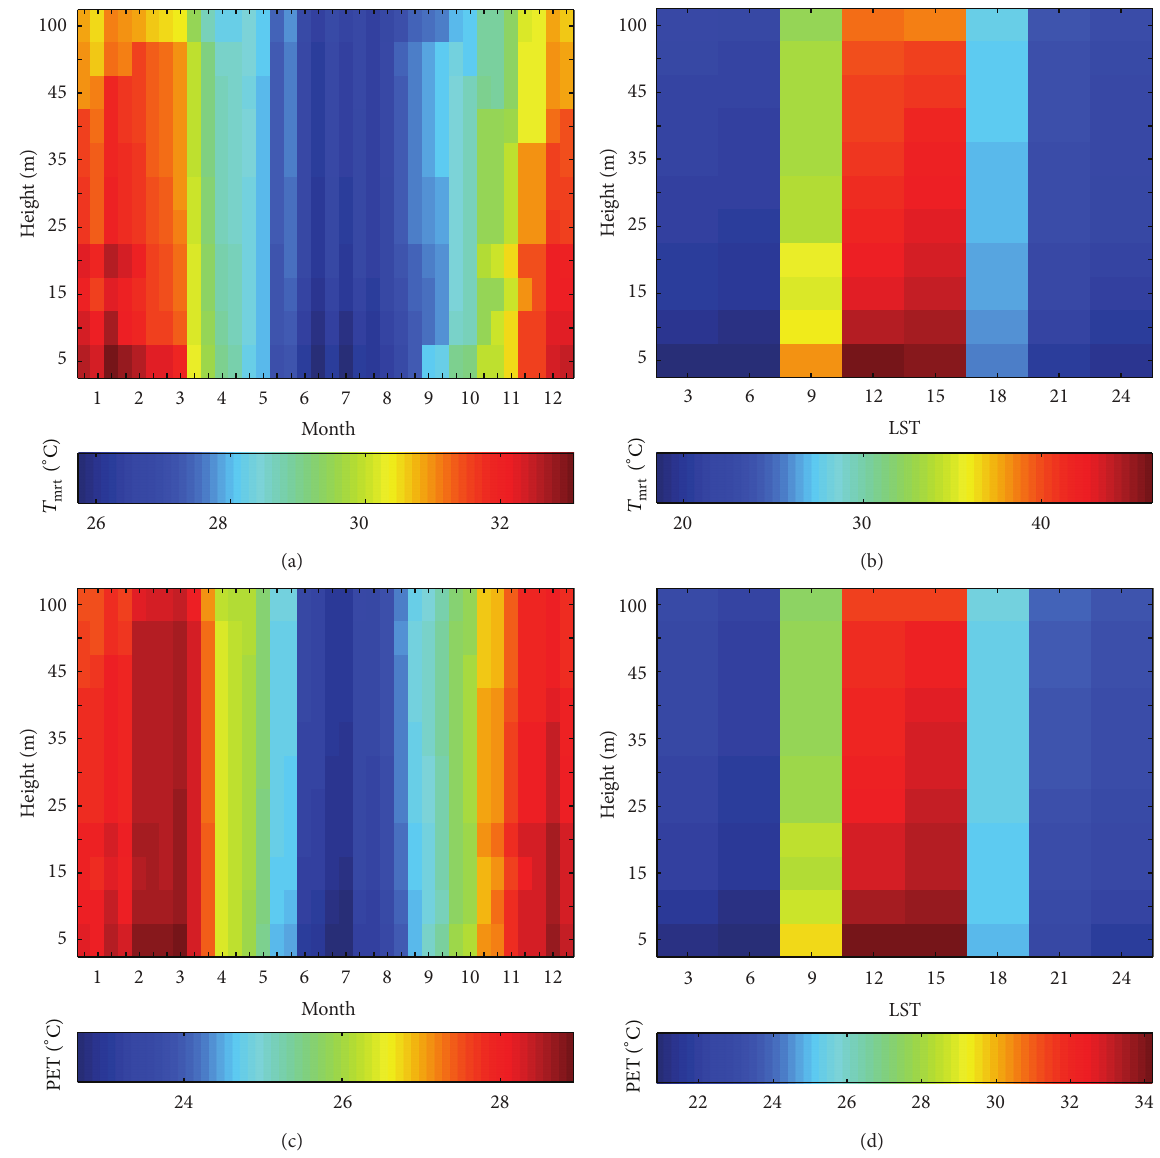
Figure 6: Effects of increasing buildings’ height on the temporal distribution of 𝑇 and the diurnal cycle (b). The corresponding thermal comfort distribution is shown in terms of PET index ((c) and